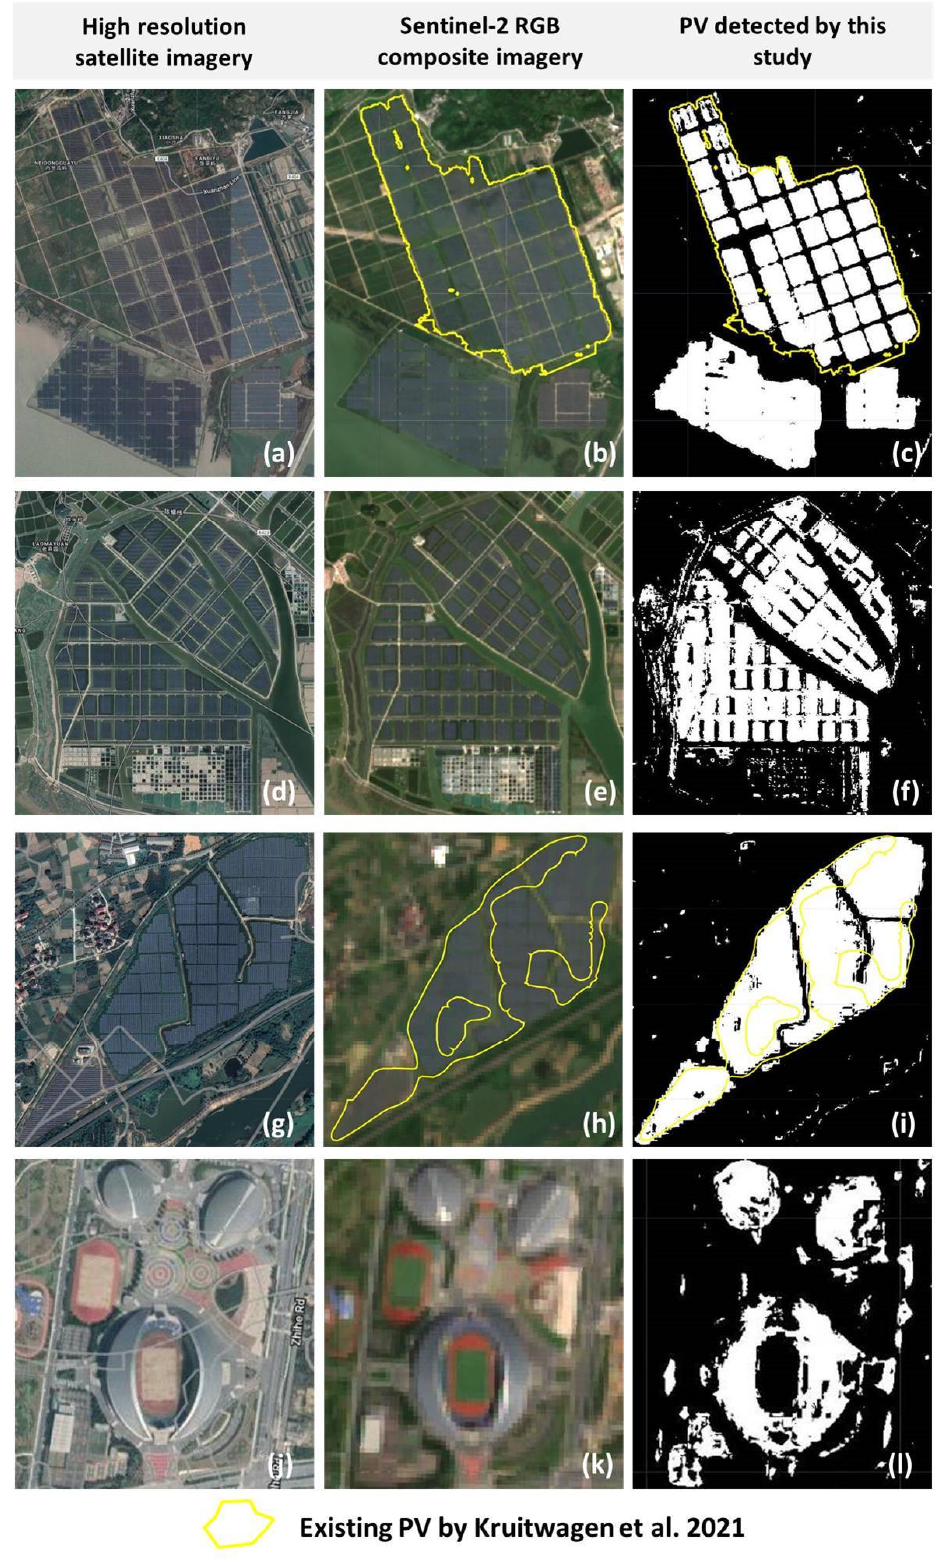
Figure 7. Classification results in Zhejiang Province ( a – c ) 121.32°E, 28.16°N; ( d – f ) 121.51°E, 29.16°N; ( g – i ) 118.71°E, 28.82°N; ( j – l ) 119.64°E, 29.05°N [12].